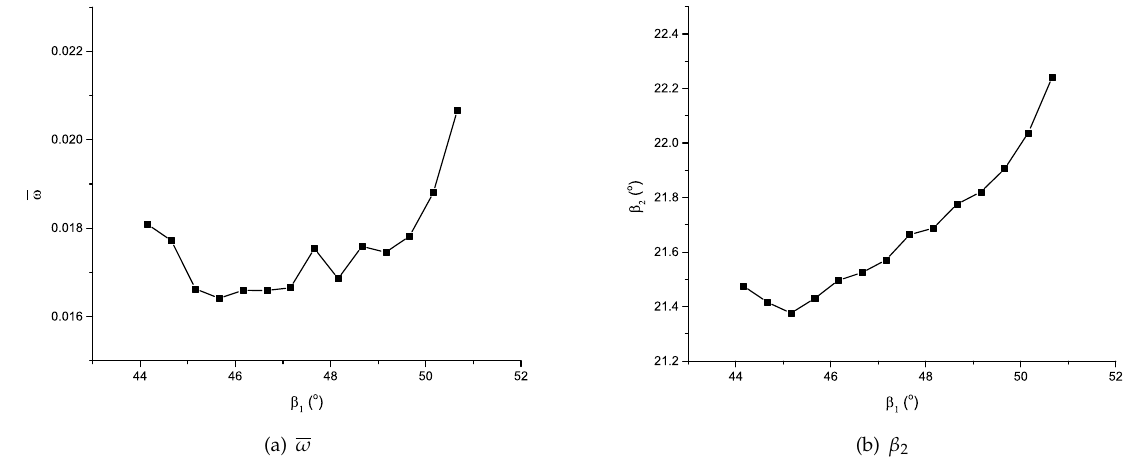
Figure 10. Aerodynamic performance curves of the initial